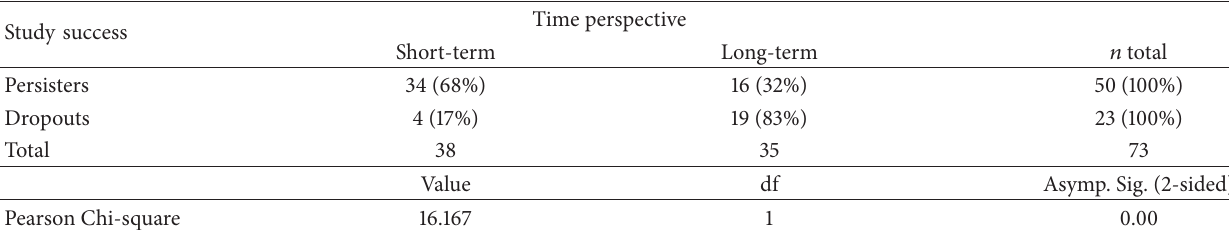
Table 1: Difference in time perspective between persisters and dropouts ( 𝑛 = 73